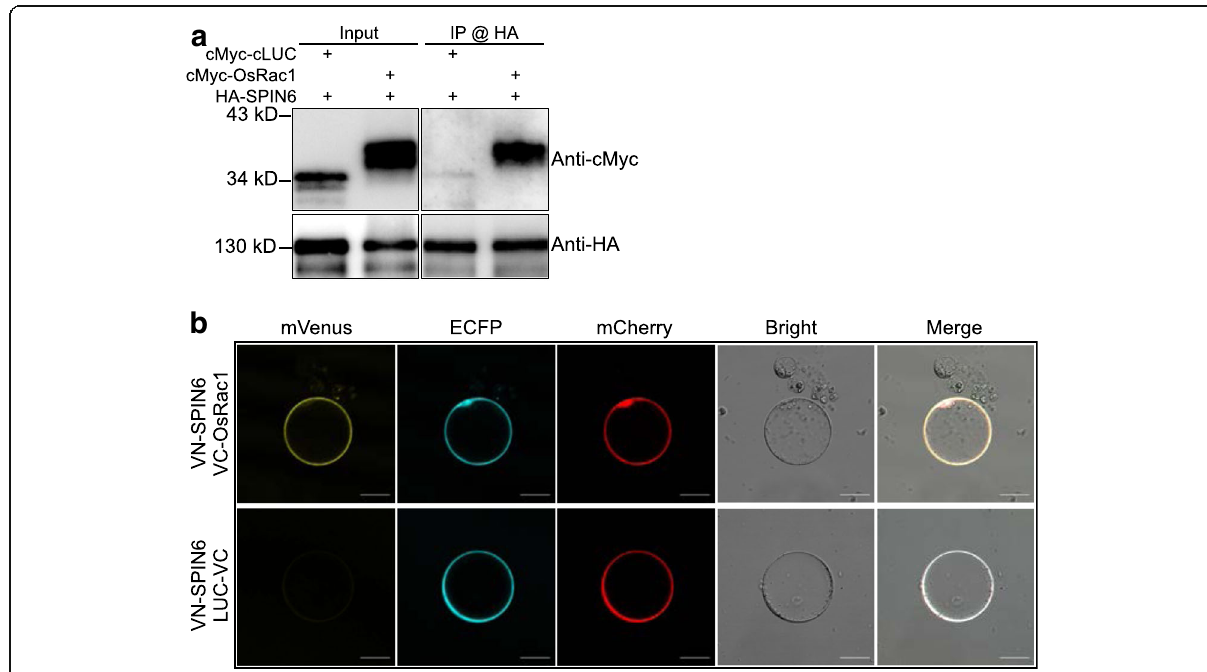
Fig. 3 Applications in protein transient expression and protein-protein interactions. a Application for protein transient expression and Co-IP assay. Plasmids pRTVnHA-SPIN6, pRTVnMyc-OsRac1, and control pRTVnMyc-cLUC were used to express HA- or cMyc-tagged protein. cLUC (417 – 568) , C terminal of luciferase. b Application for BiFC assay. BiFC plasmids pRTVnVN-SPIN6, pRTVnVC-OsRac1, and control pRTVcVC-LUC were used for the interaction assay between SPIN6 and OsRac1. LUC, luciferase. Bar = 20 μ